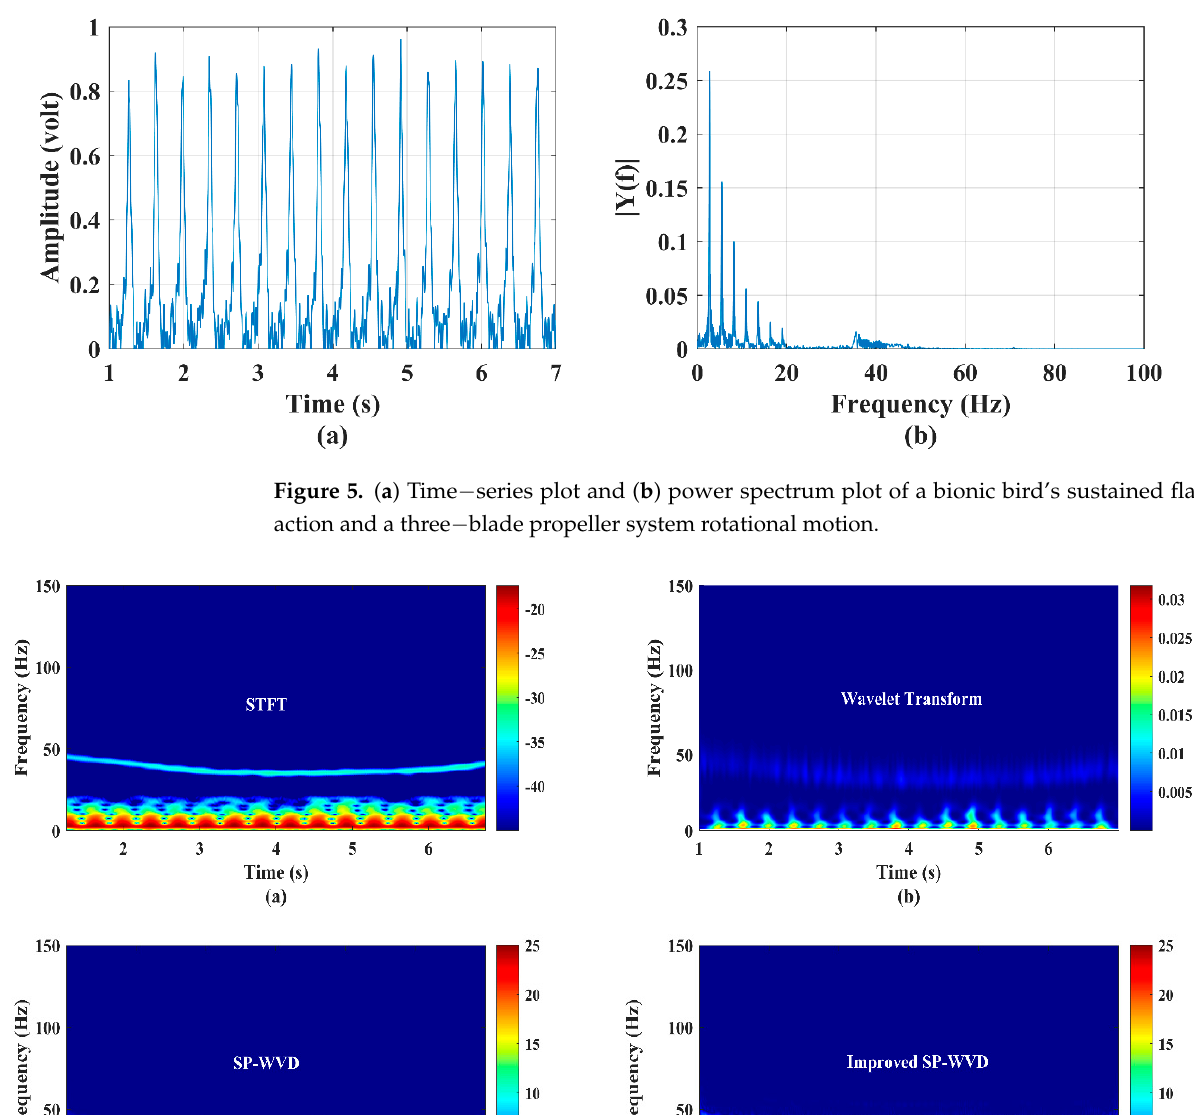
Figure 5. ( a ) Time − series plot and ( b ) power spectrum plot of a bionic bird’s sustained flapping action and a three − blade propeller system rotational motion.